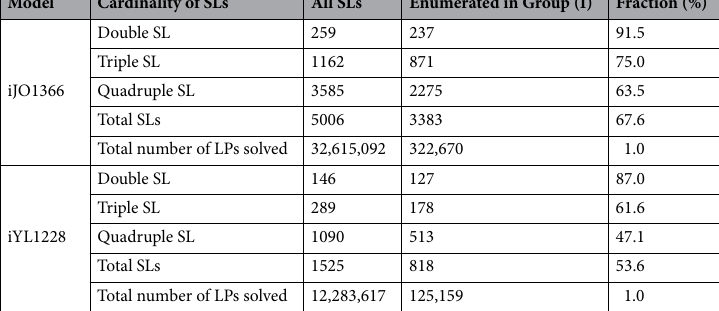
Search through a specific list of targets